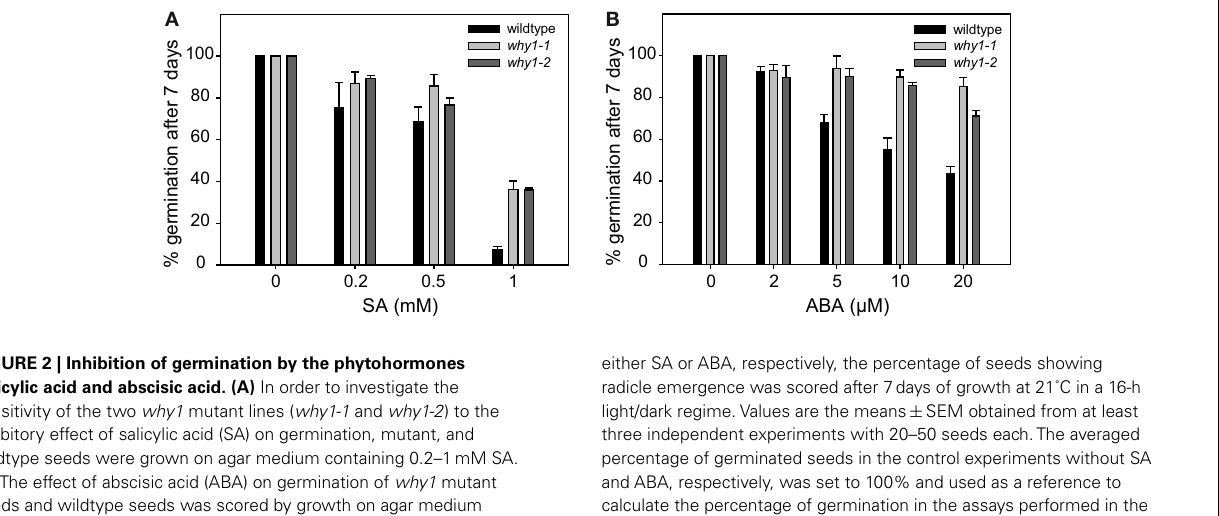
FIGURE 2 | Inhibition of germination by the phytohormones salicylic acid and abscisic acid. (A) In order to investigate the sensitivity of the two why1 mutant lines ( why1-1 and why1-2 ) to the inhibitory effect of salicylic acid (SA) on germination, mutant, and wildtype seeds were grown on agar medium containing 0.2–1mM SA. (B) The effect of abscisic acid (ABA) on germination of why1 mutant seeds and wildtype seeds was scored by growth on agar medium containing 2–20 µ M ABA. For germination assays in the presence of